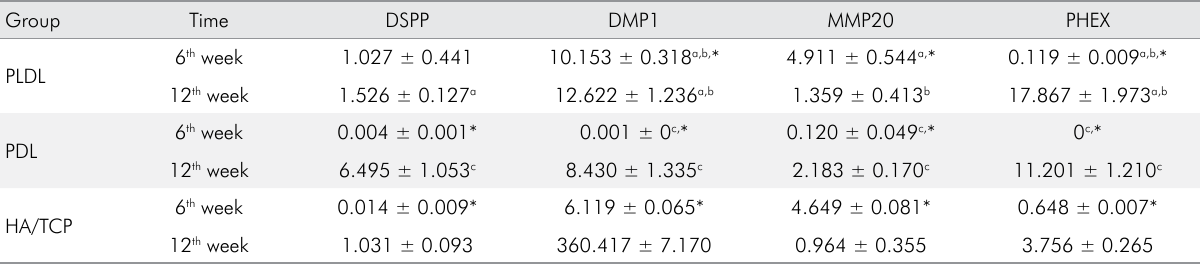
Table. The fold change rates of DSPP, DMP1, MMP20 and PHEX (mean ± std). The superscripts indicate statistically significant differences between the groups (p < 0.05).